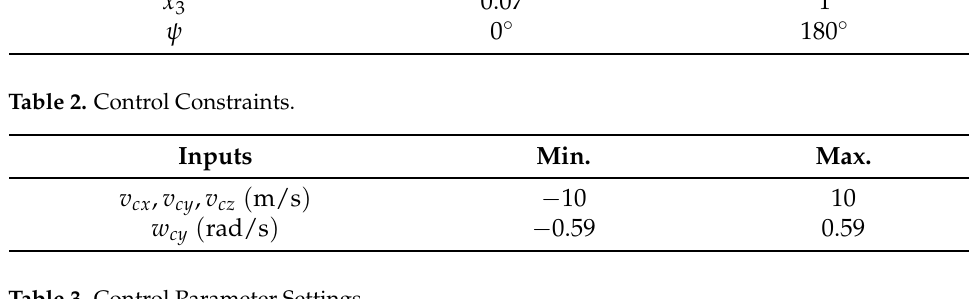
Table 3. Control Parameter